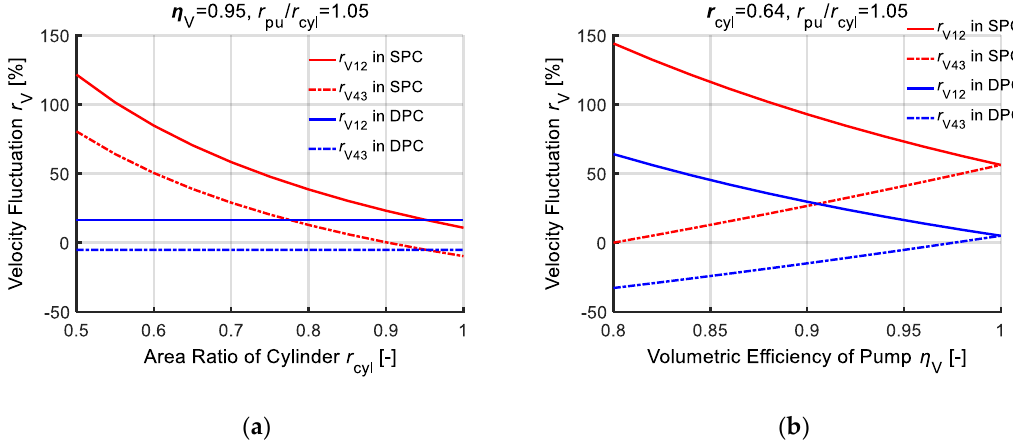
Figure 4. The velocity fluctuation percentages of the SPC and the DPC from Q1 to Q2 and from Q4 to Q3: ( a ) η V = 0.95, r pu / r cyl = 1.05 and 0.5 < r cyl < 1, ( b ) r cyl = 0.64, r pu / r cyl = 1.05 and 0.8 < η V < 1.